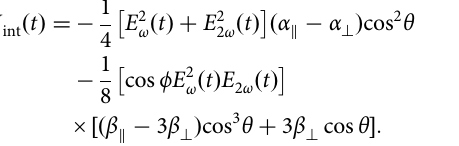
Figure 1 schematically shows our quantum control strategy. than the fundamental ( ω ) pulse, due to the second-order the nanosecond two-color laser pulse, virtually only the ω pulse enough, the molecules in both j